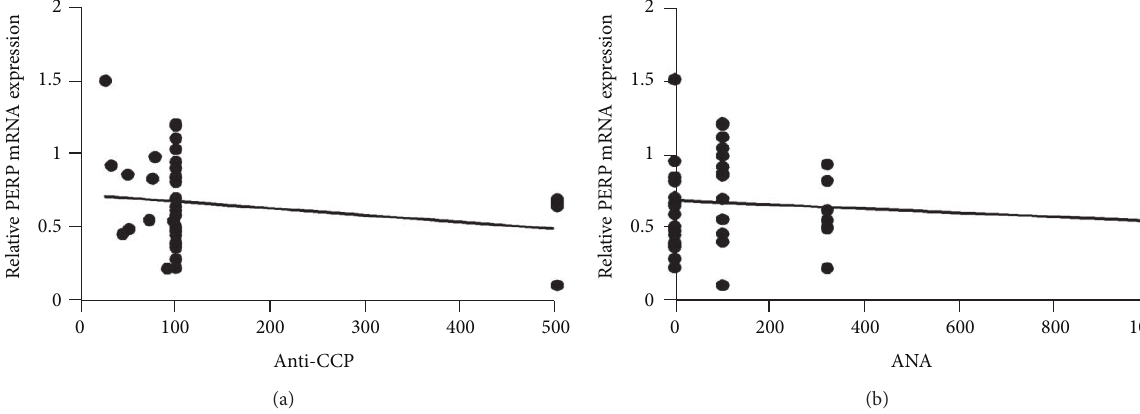
Figure 4: Correlations of PERP mRNA expression on PBMCs in RA patients with DAS28 and RF. The PERP mRNA expression levels do not have correlations with anti-cyclic citrullinated protein antibodies (anti-CCP) (a) ( 𝑃 > 0.05 ) and antinuclear antibodies (ANA) (b) ( 𝑃 > 0.05 ). 𝑃 < 0.05 deems significantly different.